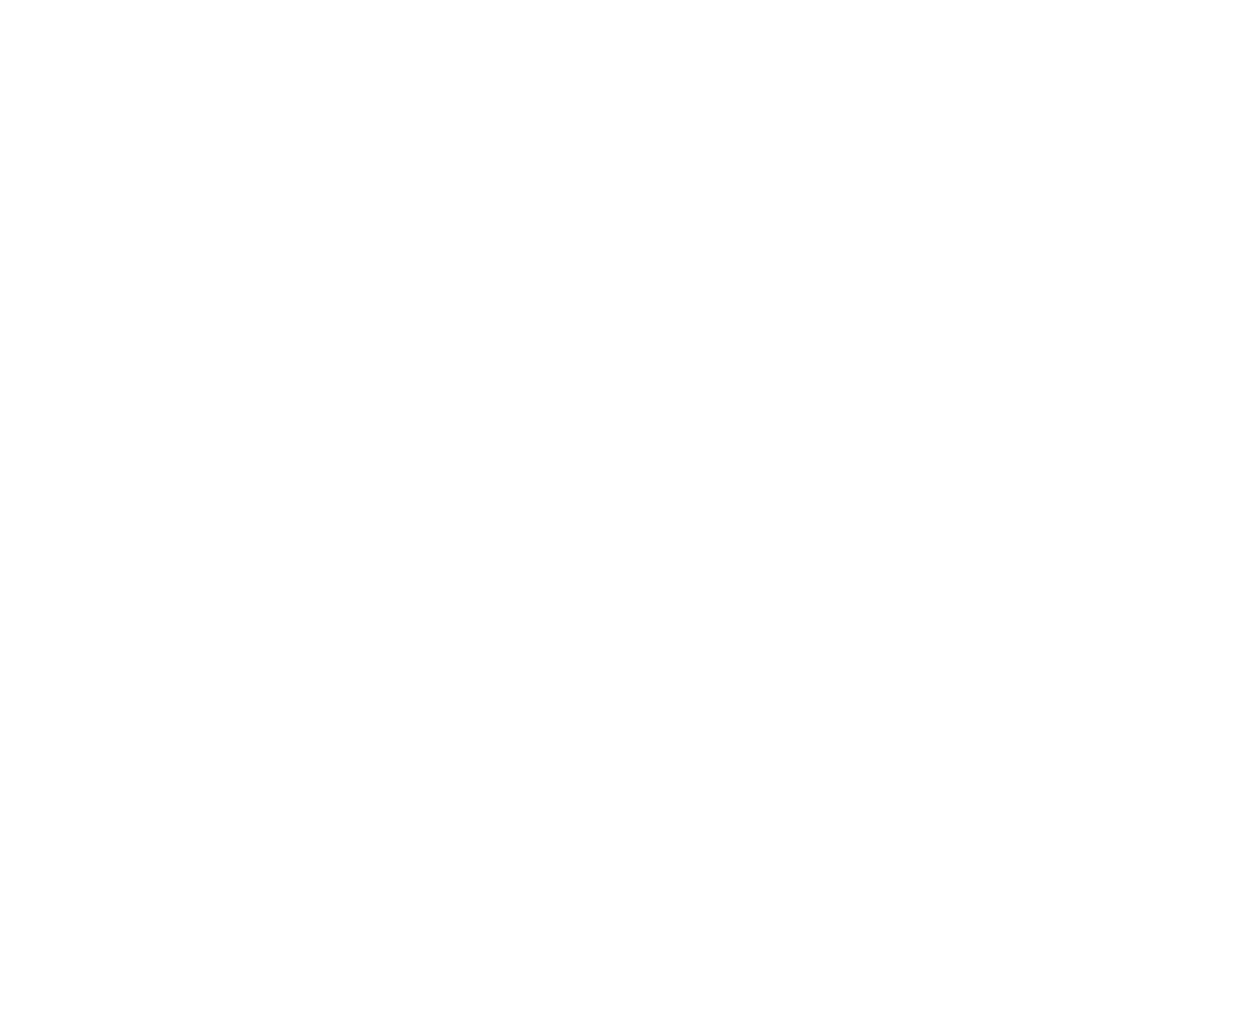
Frontiers in Cellular and Infection Microbiology |